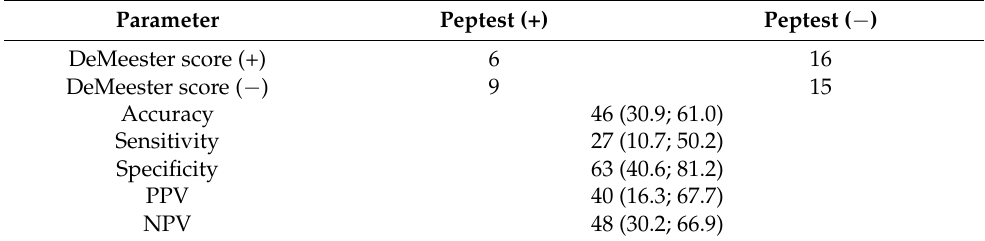
Values are the number of patients or diagnostic measure with the 95% confidence interval, as indicated. PPV— positive predictive value, NPV—negative predictive